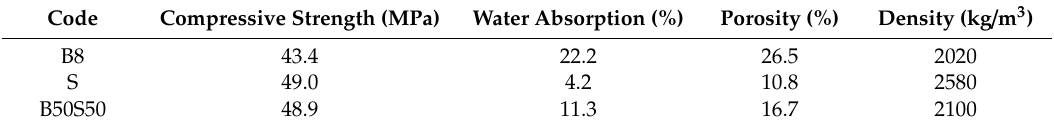
Table 4. Physical properties of selected specimens (H 2 O / Na 2 O = 18.2, curing at 90 ◦ C and ageing for 7 days).